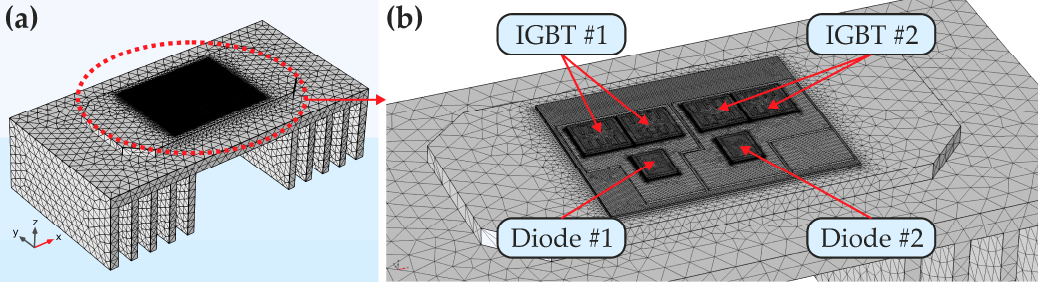
Figure 2. ( a ) Full image; and ( b ) detail of the 3-D mesh of the module depicted in Figure 1.